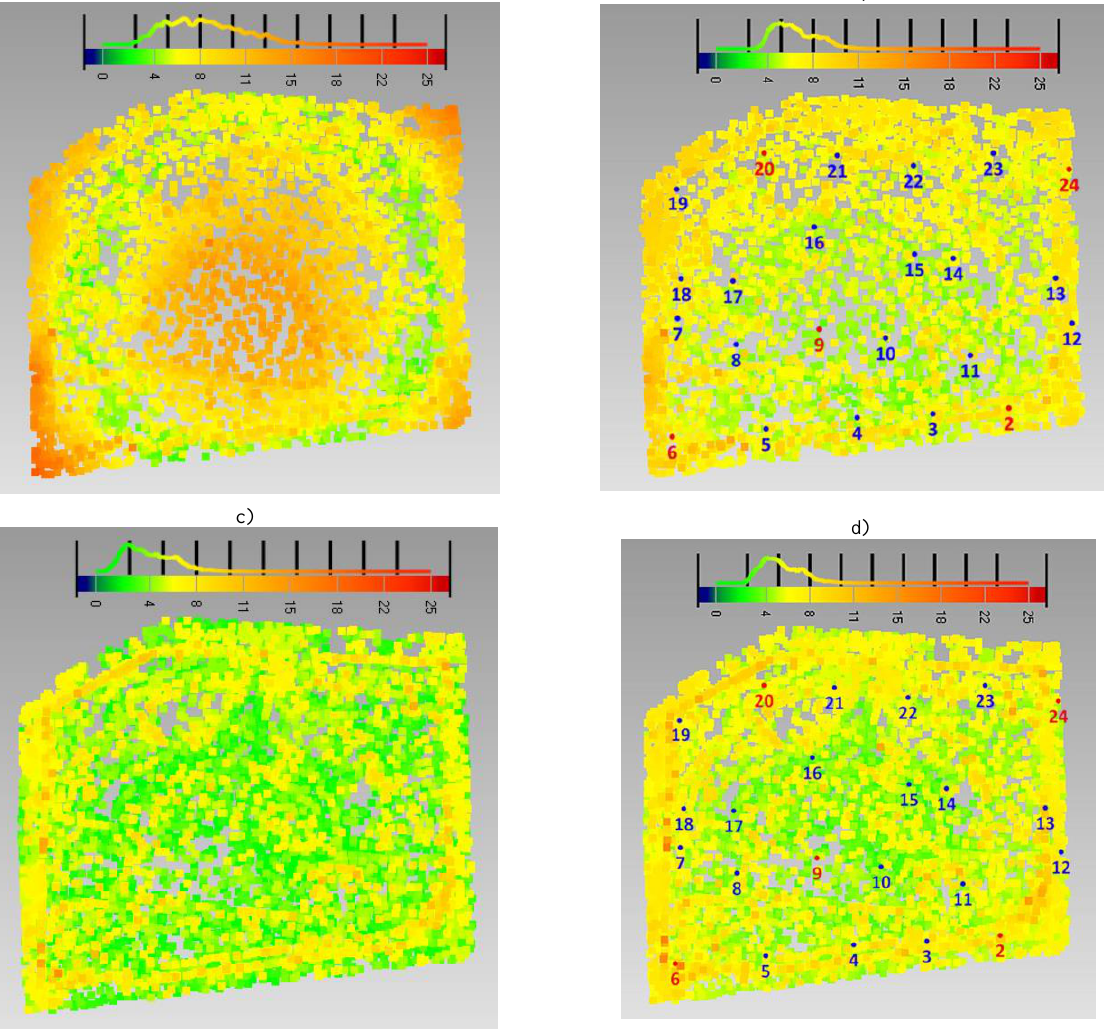
Figure 7: 3D point uncertainty as a color map: free network with only vertical images (a), contrained adjustment (5 GCPs) wit h only vertical images (b), free network with vertical and oblique images (c) and constrained adjustment (5 GCPs) with vertical and oblique images